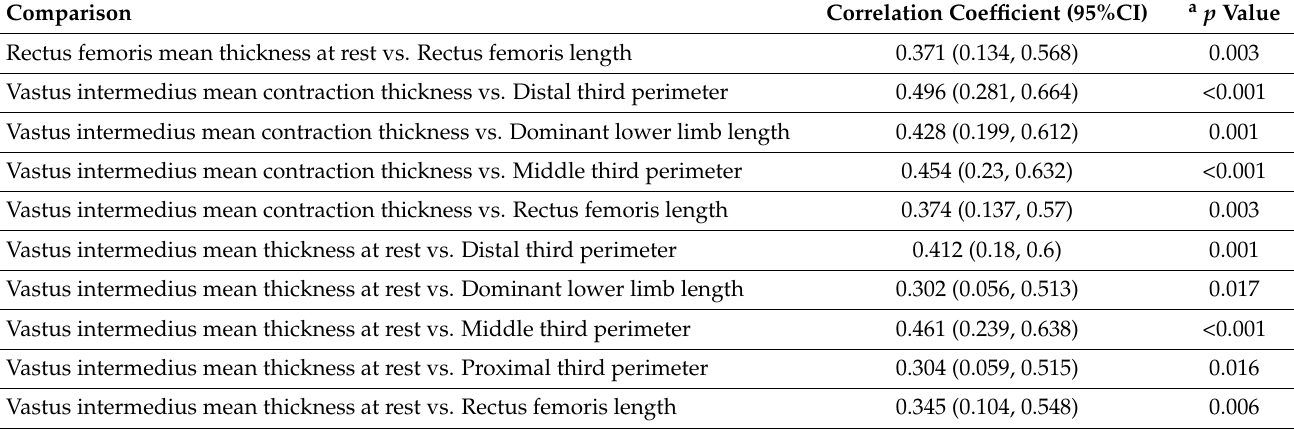
Table 4. Baseline outcomes vs. thickness measurements